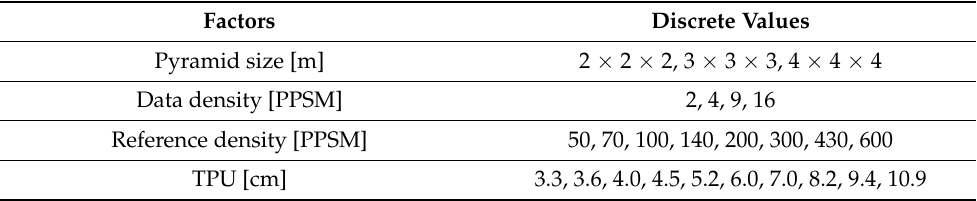
Table 4. Discrete values used in the